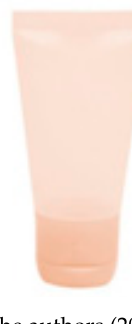
Figure 3. Slide A—Blind test transparent tubes. Source: the authors (2020).